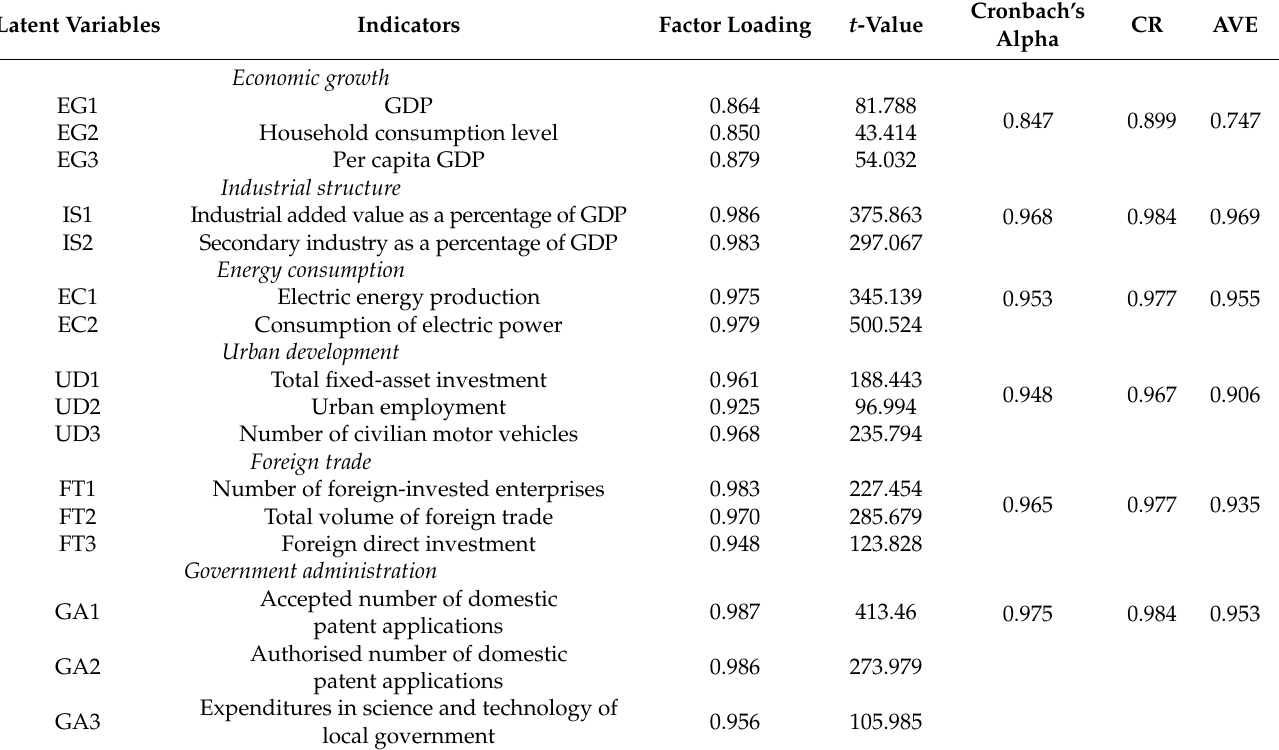
Table 1. Factor loadings, Cronbach’s alpha, composite reliability (CR), and average variance extracted (AVE). Latent